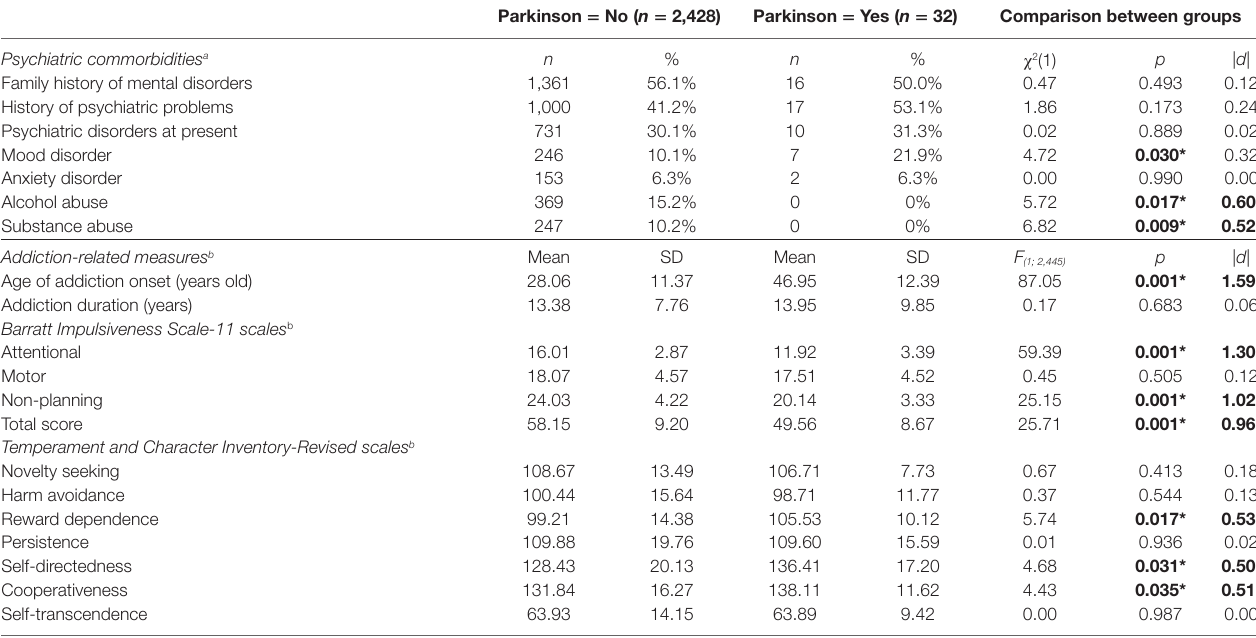
TaBle 2 | Comparison between patients with and without Parkinson disorder. Parkinson = no ( n = 2,428) Parkinson = Yes ( n = 32) comparison between